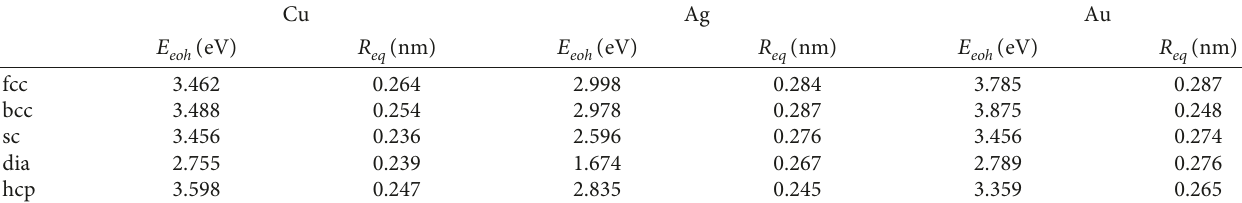
Table 2: Cohesive energy and equilibrium bond length.